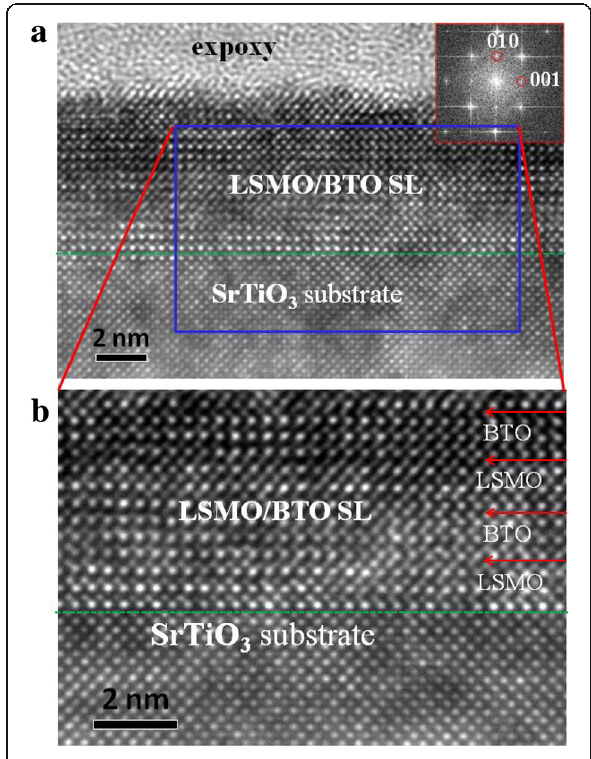
Fig. 2 a A cross-section HRTEM image of the SL-3 sample. The inset shows the corresponding FFT patterns. b The enlarged blue rectangle drawing with the interfaces between the LSMO and BTO layers indicated by red